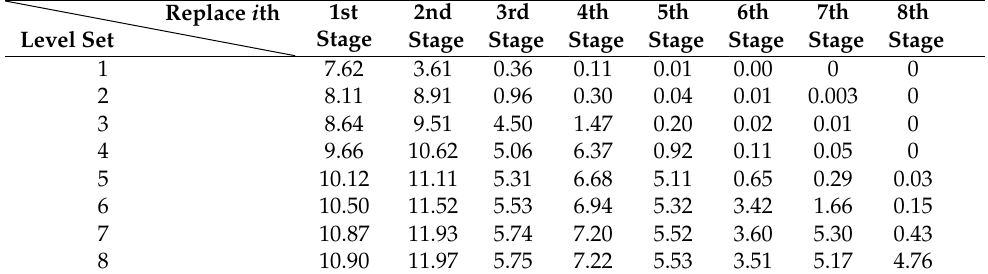
Table 7. Pressure errors of replacing all levels under partial variable conditions.